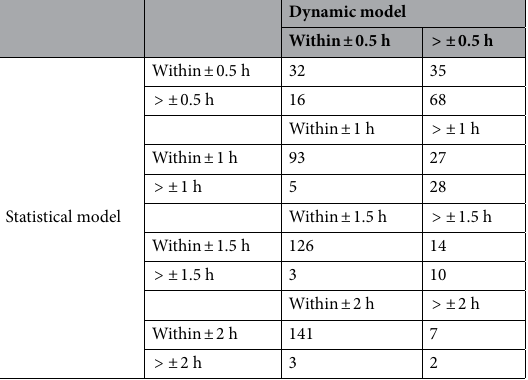
Table 3. Number of participants (N = 153) accurately predicted in both approaches (grey highlight).